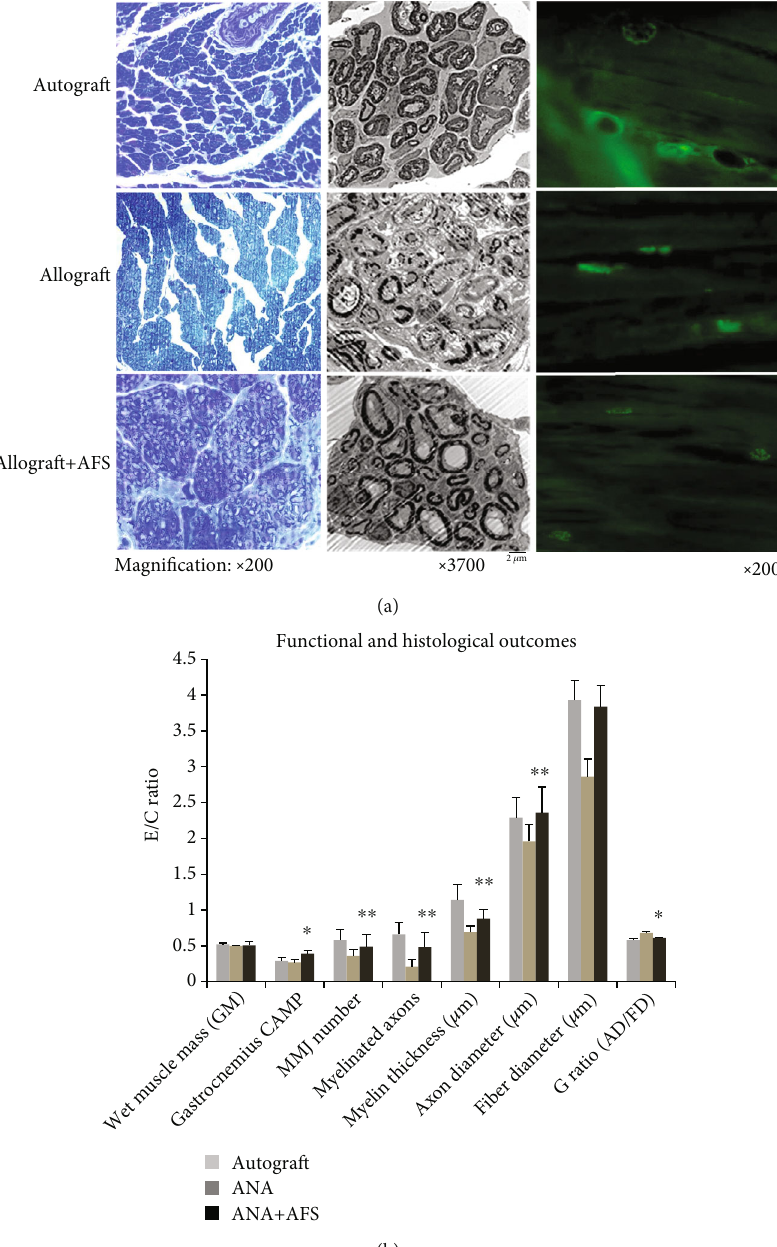
Figure 5: (a) Nerve histology at 4 months post-graft implantation. Toluidine blue staining of cross sections of nerve grafts 1mm distal to the suture site (left column, × 200 magni fi cation), electronic microscopic pictures of nerve fi bers (middle column, × 3700), and immunohistochemistry staining of NMJ (right column, × 400) in 3 experimental groups. (b) Normalized experimental hind limb to contralateral control limb measurements of functional and histological outcomes in 3 experimental groups. ∗∗ p < 0 : 01 and ∗ p < 0 : 05 , signi fi cantly di ff erent to the ANA